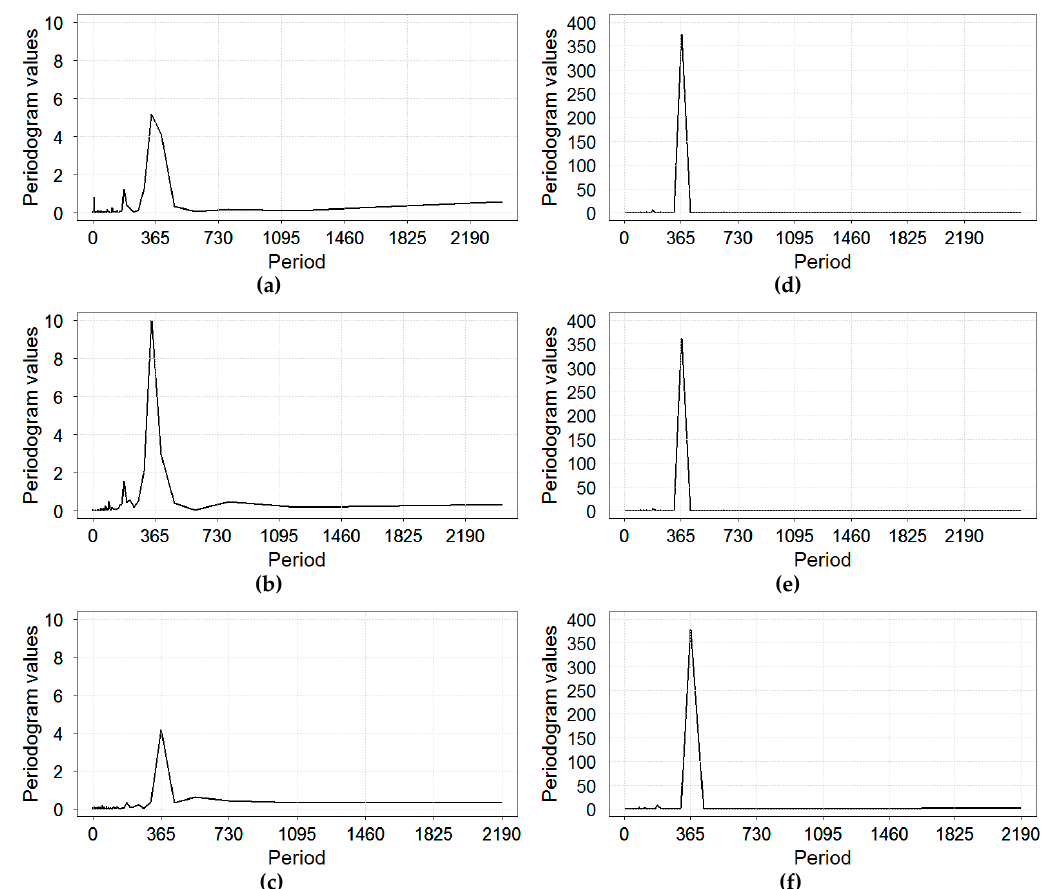
Figure 3. The periodogram spectral analysis for time series of daily rates of rotaviral infection (RI) ( a – c )